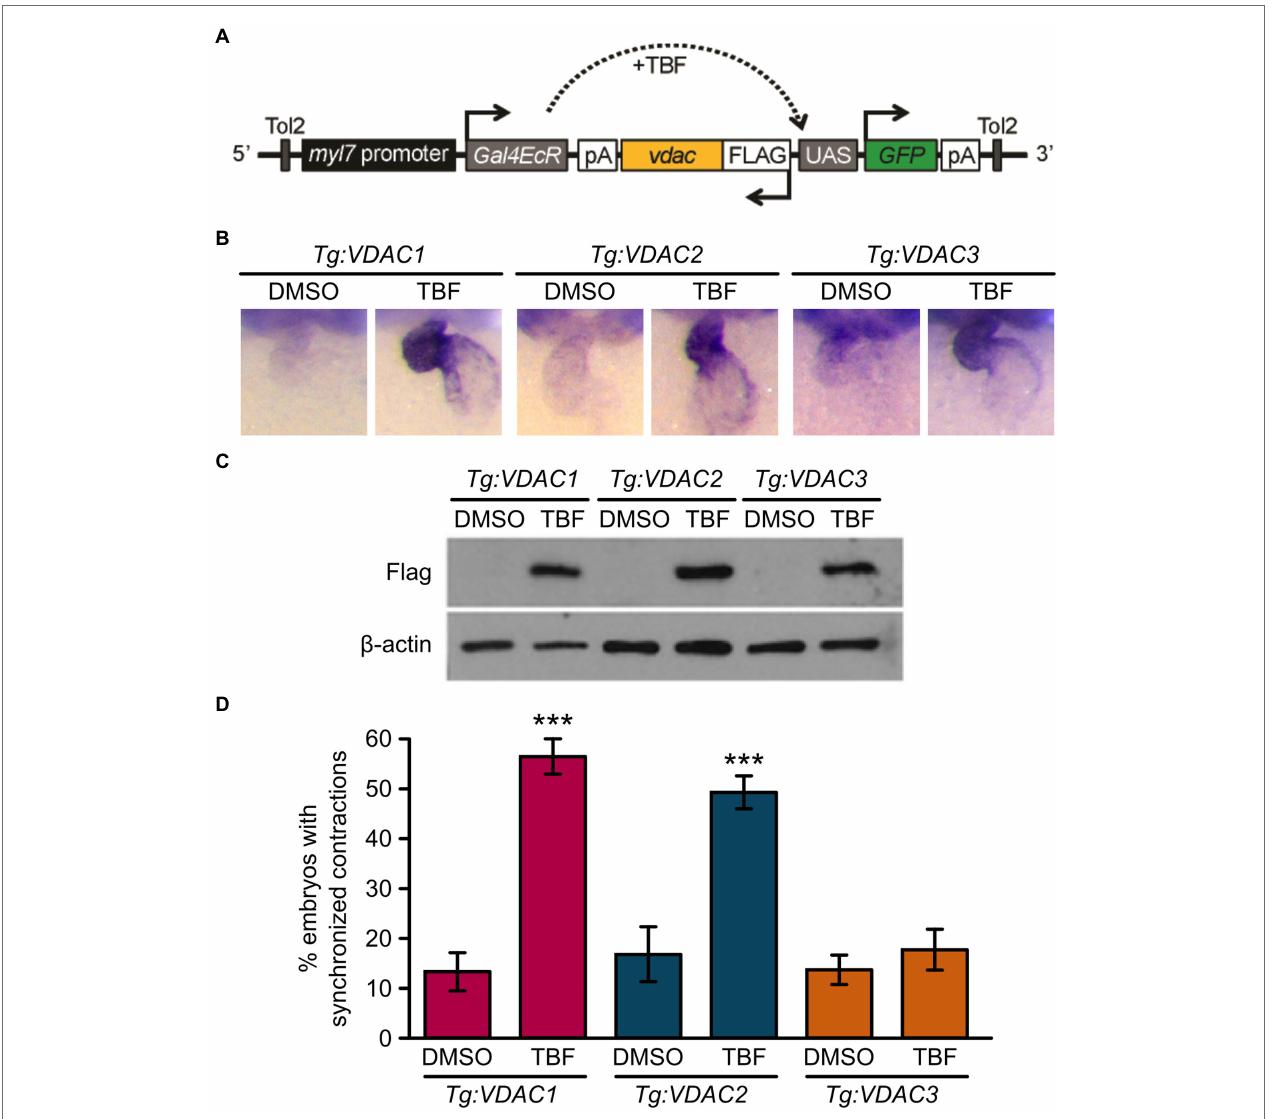
FIGURE 4 | Induction of VDAC1 and VDAC2 but not VDAC3 expression restores rhythmic cardiac contraction in transgenic tremblor/ncx1h lines. (A) Schematic diagram of VDAC transgenic construct. The cardiomyocytes-specific promoter myl7 drives Gal4-ecdysone receptor fusion protein (Gal4EcR), which becomes transcriptionally activated in response to tebufenozide (TBF), an ecdysone receptor agonist and binds to the upstream activating sequence (UAS), resulting in the simultaneous expression of both FLAG-tagged VDAC and EGFP. Transgenic lines were bred in the tremblor/ncx1h background. (B) Whole-mount in situ hybridization analysis demonstrating that VDAC expression is induced specifically in the heart upon TBF treatment in transgenic zebrafish ( Tg:VDAC ). Embryos were treated with either DMSO or TBF from 24 hpf until they were fixed for in situ hybridization at 48 hpf. (C) Western blotting of 32 hpf transgenic embryo lysate with an anti-FLAG antibody showing that VDAC protein expression is induced after embryos are treated with TBF. β -actin was used as a loading control. (D) While only 13.5 ± 3.6% of DMSO-treated Tg:VDAC1; tremblor/ncx1h embryos exhibit rhythmic cardiac contraction (N = 3, n = 233), 56.72 ± 3.5% of TBF-treated Tg:VDAC1; tremblor/ncx1h embryos established rhythmic contraction (N = 3, n = 238). Similarly, as opposed to only 16.8 ± 5.7% of DMSO-treated Tg:VDAC2; tremblor/ncx1h embryos (N = 3, n = 161), 49.6 ± 3.1% of TBF-treated Tg:VDAC2; tremblor/ncx1h embryos showed cardiac contraction (N = 3, n = 227). In contrast, the effect of TBF-induced overexpression is minimal in Tg:VDAC3; tremblor/ncx1h (13.7 ± 2.9%, N = 3, n = 283 in DMSO-treated embryos compared to 17.9 ± 4.0%, N = 3, n = 373 in TBF-treated embryos). Overall rescue percentages represent the mean rescue percentage ± s.e.m. from N independent experiments, using a total of n